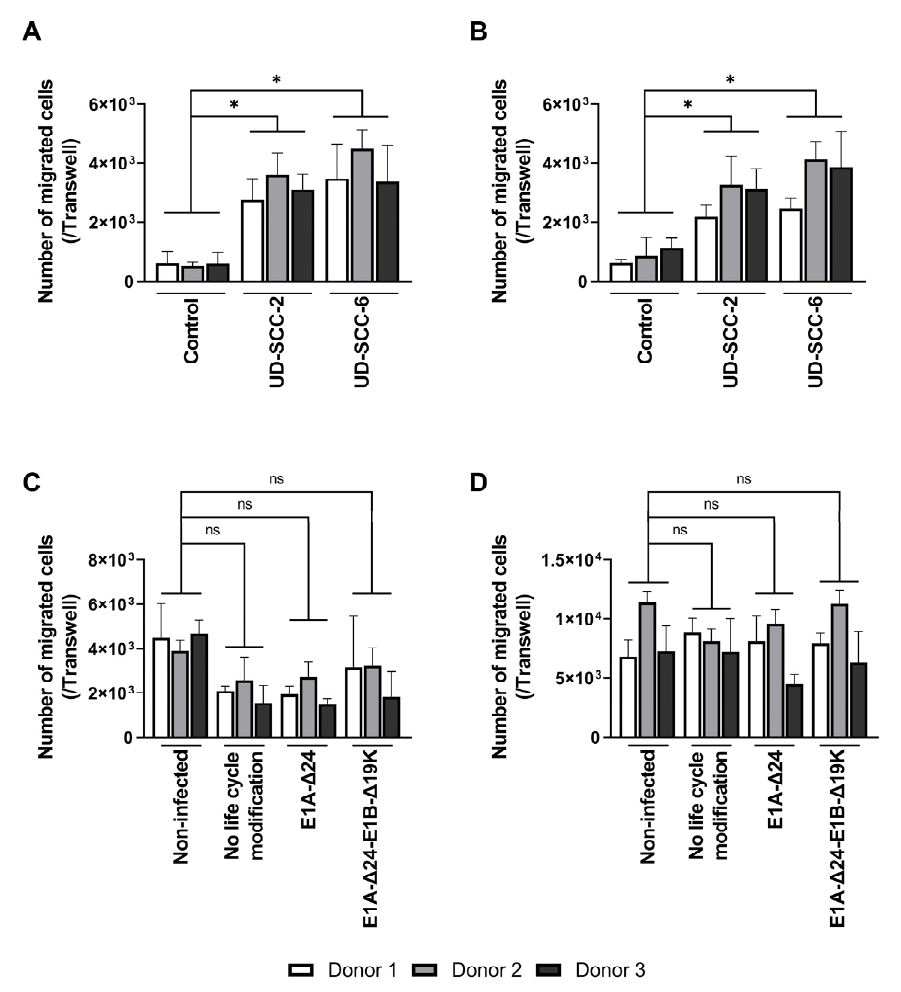
Figure 5. Migration of hMSCs toward HNSCC ‐ conditioned medium is not inhibited by infection with replication-competent HAdV-5. ( A , B ) 2 × 10 4 non-infected BM- ( A ) and A-hMSCs ( B ) were seeded into the upper well of a Boyden chamber, while the lower well contained unconditioned or cell line-conditioned medium. After 18 h, the total number of migrated hMSCs at the bottom side of the TC insert was determined. ( C , D ) BM- ( C ) and A-hMSCs ( D ) were infected with the indicated replication-competent HAdV-5-HexPos3 virus (pMOI 900) and transferred to the upper well of a Boyden chamber 3 h later. The lower well contained UD-SCC-2-conditioned medium. After 18 h, the total number of migrated hMSCs was determined. Results are given as mean ± standard deviation of biological triplicates. One-way ANOVA with subsequent Tukey’s multiple comparison was used for statistical analysis (* = p ≤ 0.05, ns = not significant).